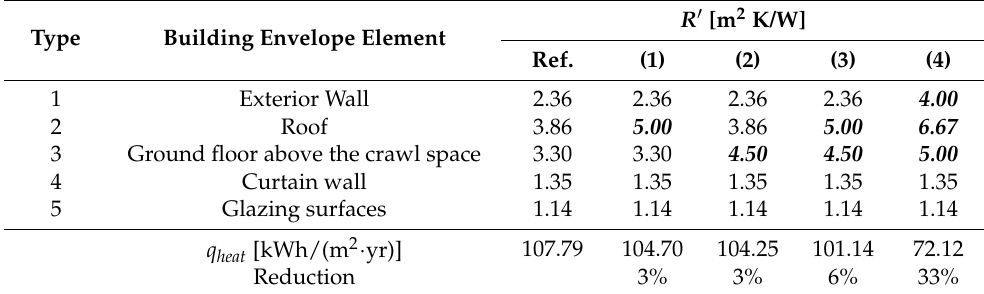
Table 9. Results in the parametrisation of R (cid:48) value for each building envelope component–correlation with the energy consumption for heating q heat